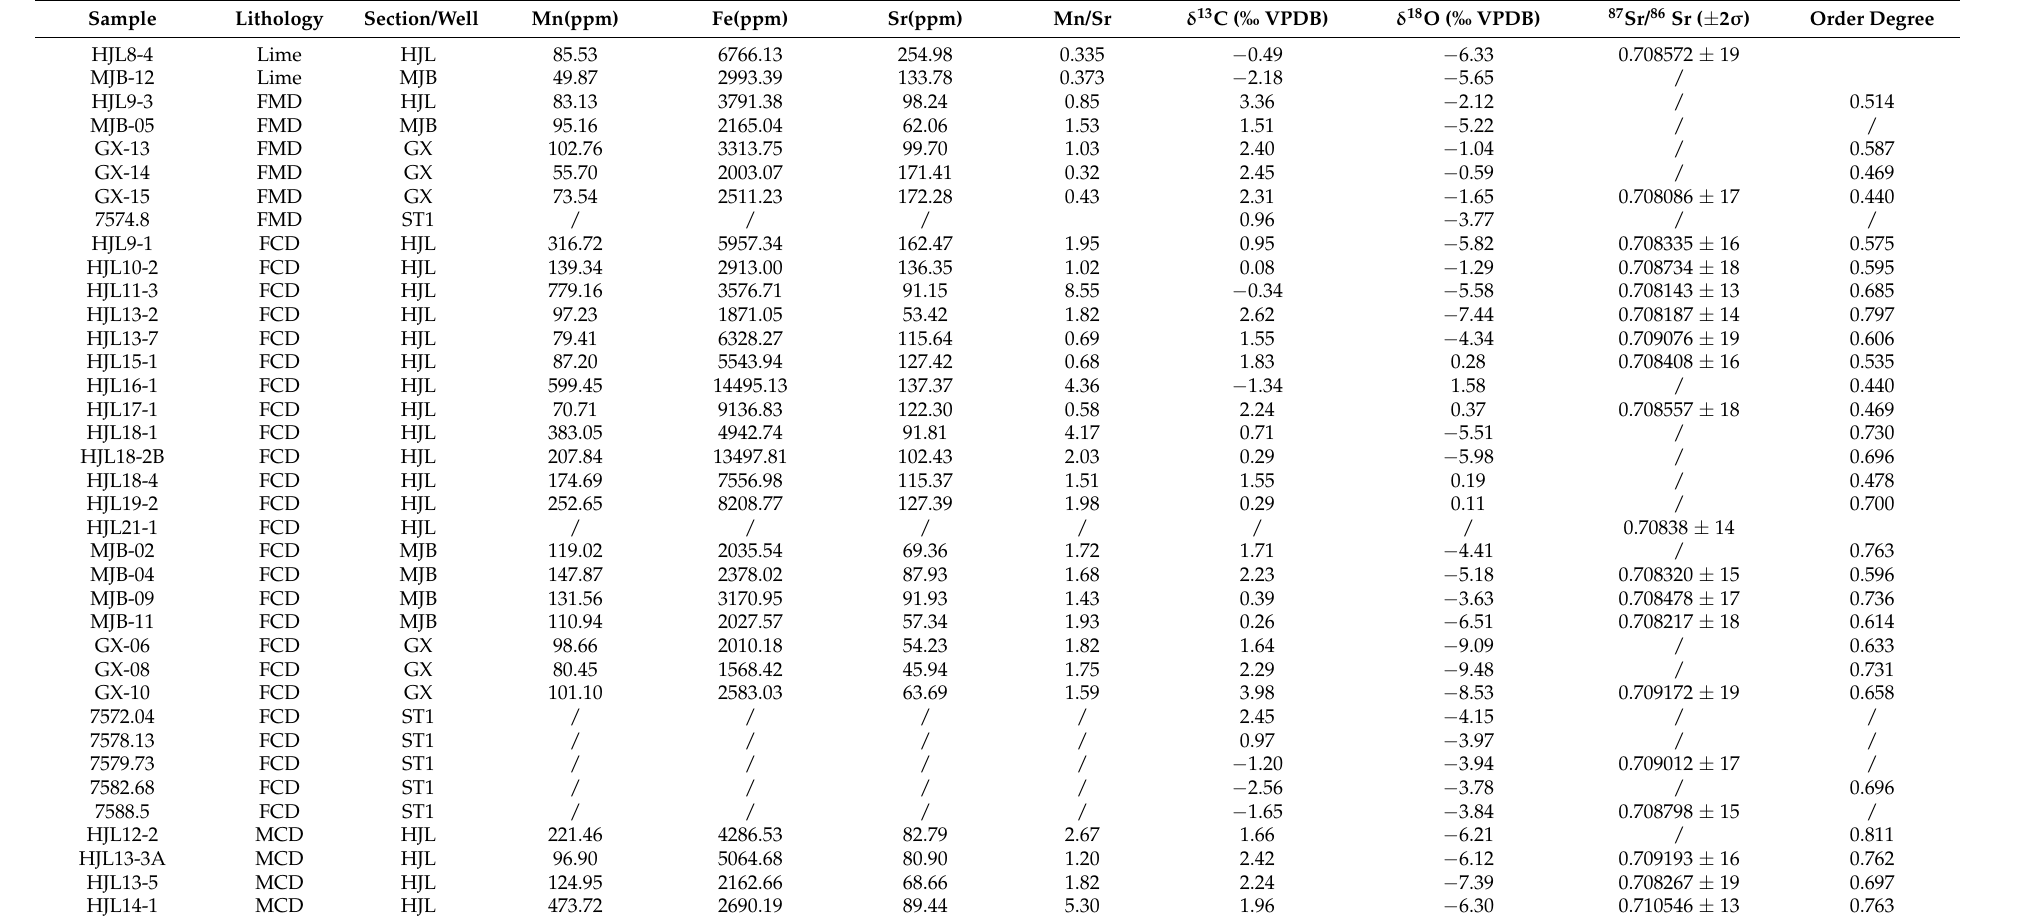
Table 1. Isotopic data ( δ 13 C, δ 18 O and 87 Sr/ 86 Sr) of dolomites in the Middle Devonian carbonate successions, northwestern Sichuan